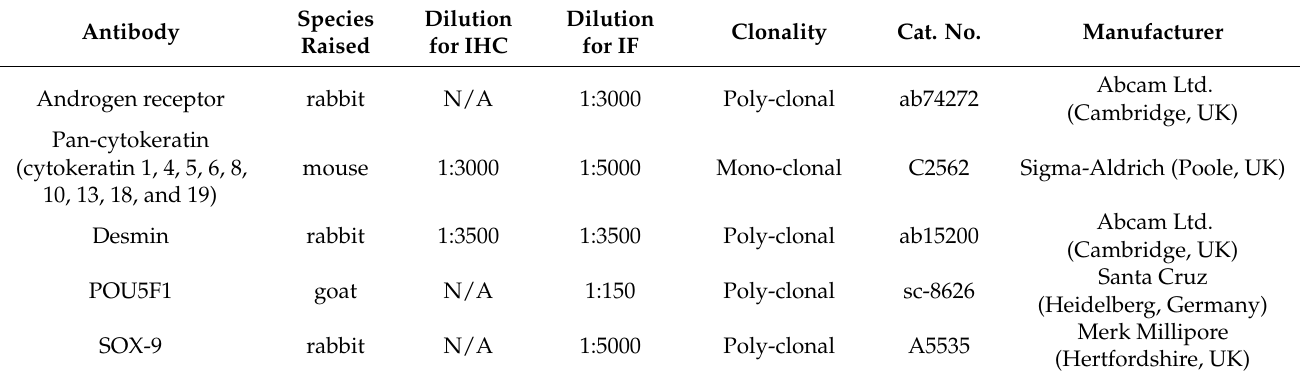
Table 1. Summary of Primary antibodies for immunohistochemistry and